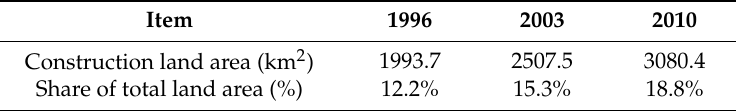
Table 1. Urban land area changes in Beijing.